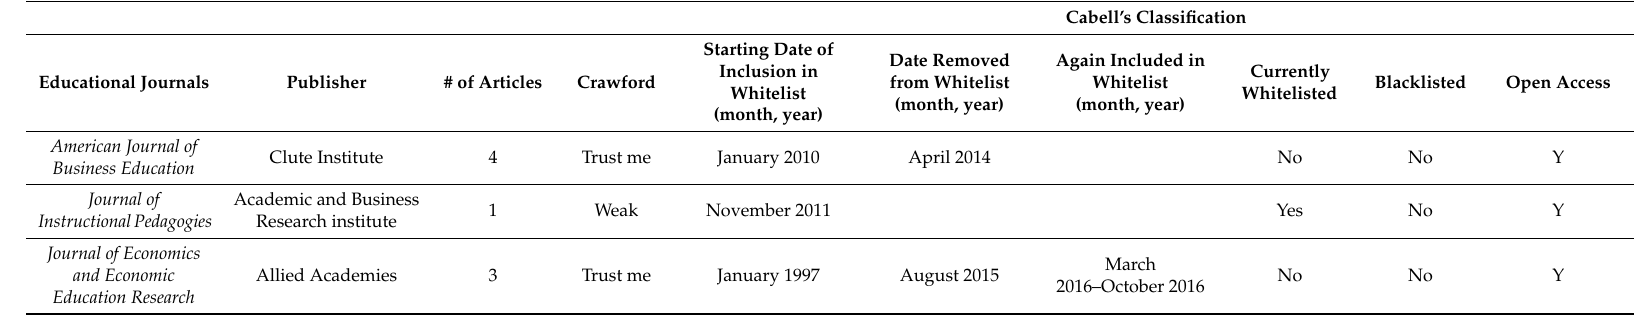
Table 4. Business educational publications of research faculty members in journals included in Beall’s 2016 list of